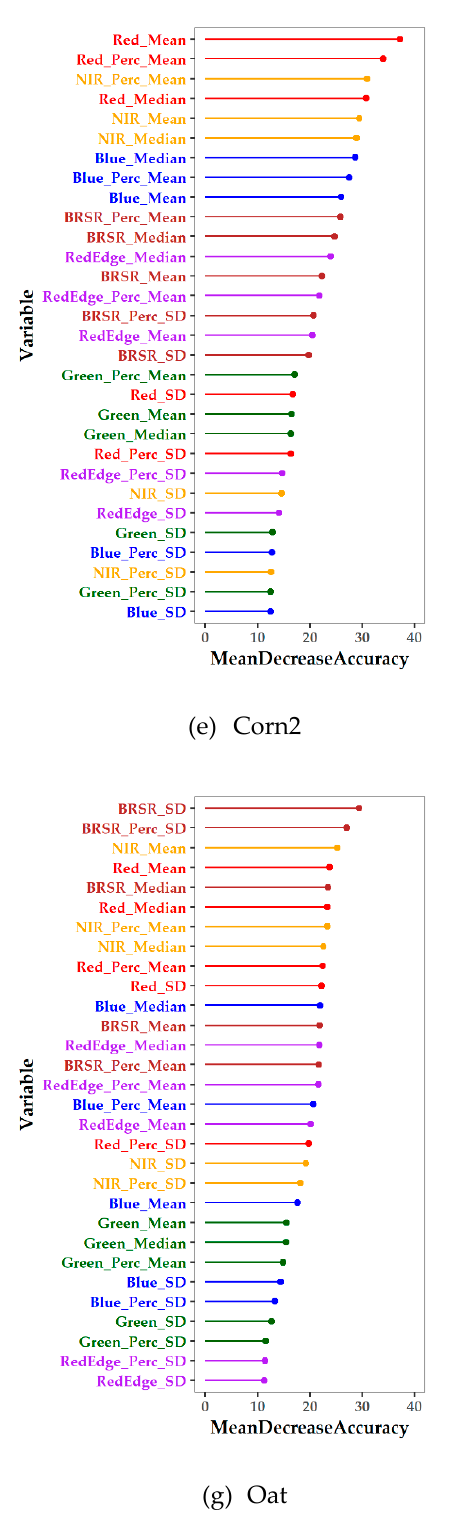
Figure 5. Variable importance plot from the geographic object-based image analysis random forest classification for the following fields: ( a ) Barley1; ( b ) Barley2; ( c ) Barley3; ( d ) Corn1; ( e ) Corn2; ( f ) Corn3; ( g ) Oat.